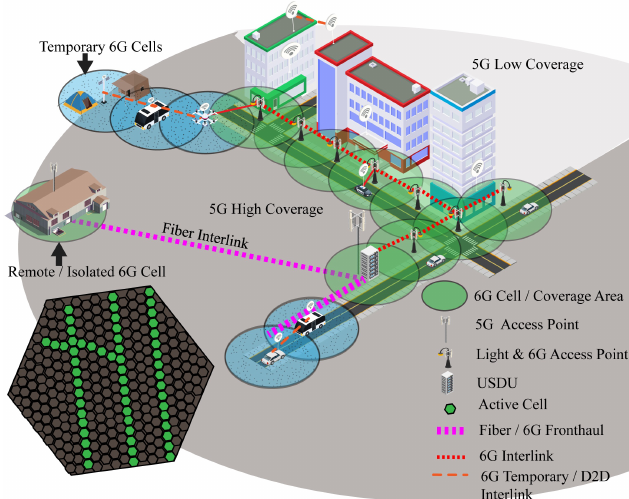
Figure 7. Structure of 6G